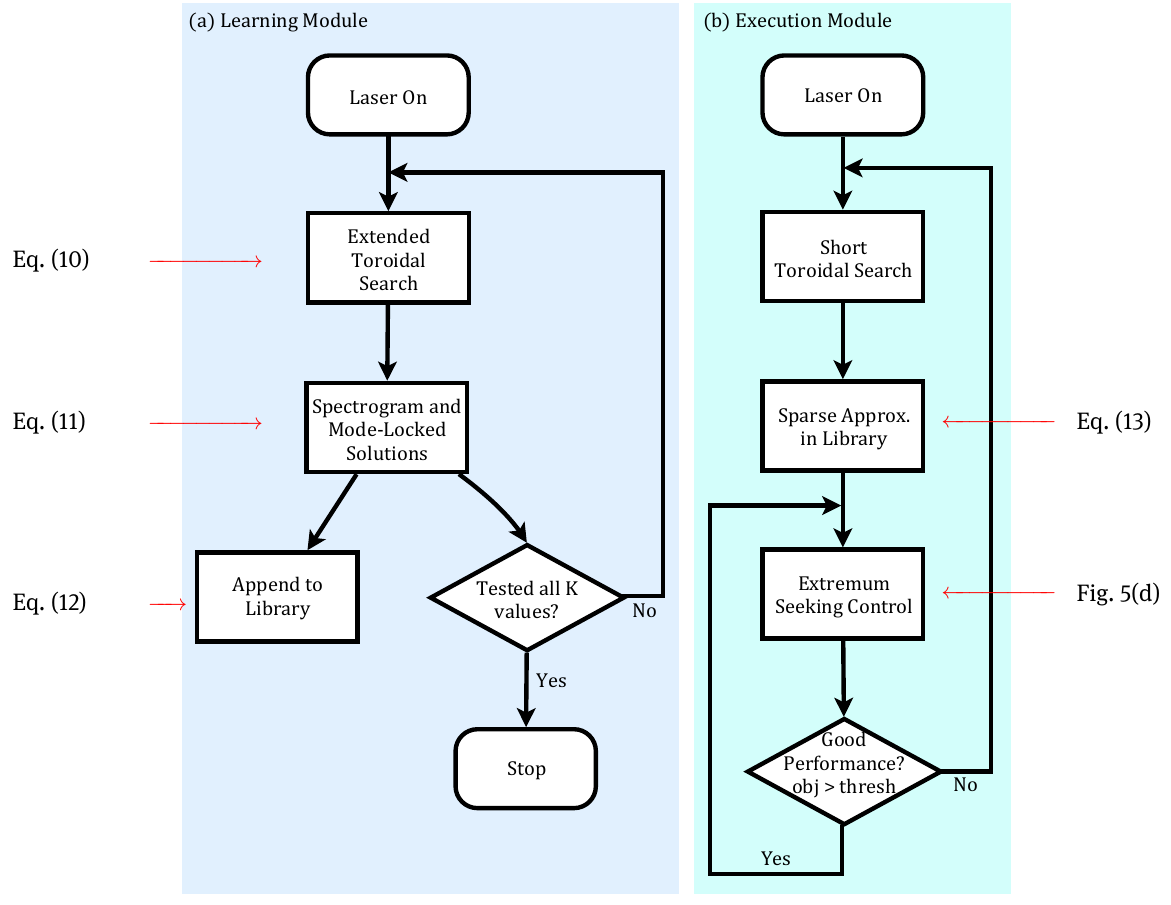
Figure 6: Flow chart showing the (a) training and (b) execution modules associated with the mode-locked laser cavity. The flow chart is annotated with key mathematical concepts and equations from the paper. Such a training and execution scheme can be applied a wide variety of photonic and optical